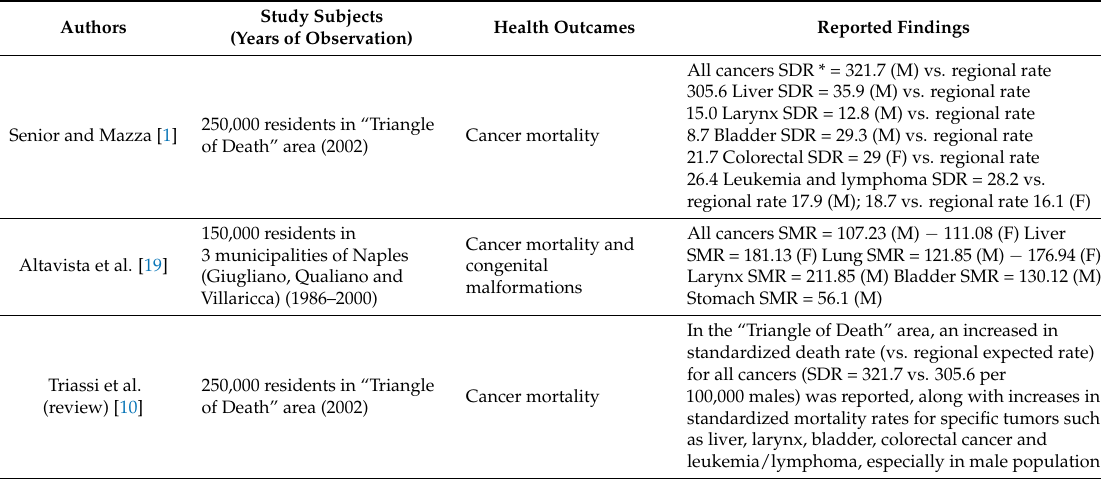
Table 2. Summary table of studies on health